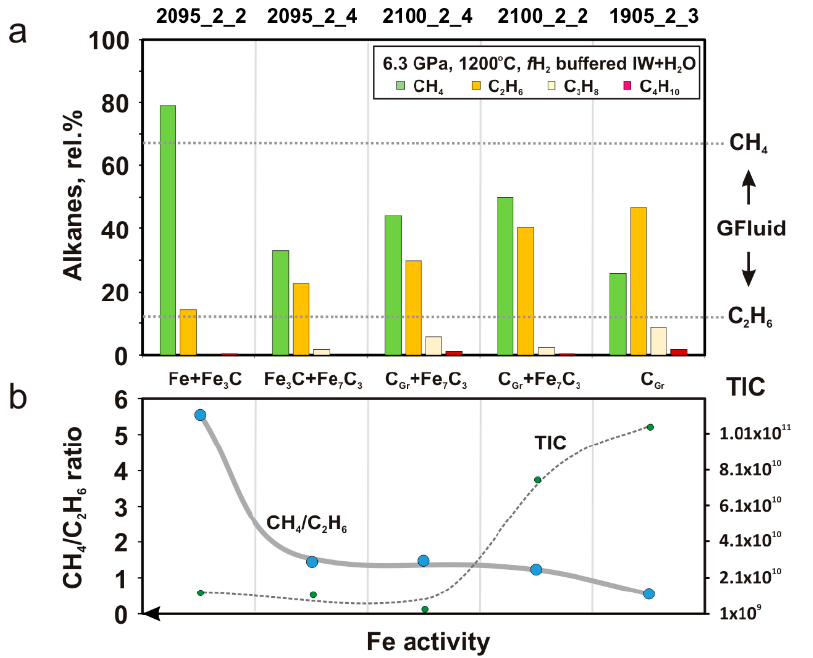
Figure 5. ( a ) Contents of light alkanes C 1 –C 4 and CH 4 / C 2 H 6 ratio in quenched fluids obtained at 1200 ◦ C in samples with bu ff ered Fe and C activity in Pt capsules. Data on run 1905_2_3 are from [25]. CH 4 and C 2 H 6 contents calculated with GFluid [60] on the right are shown for comparison. ( b ) TIC (total ion count) values obtained by GC-MS on the right characterize semi-quantitatively the amount of fluid in the capsule after the